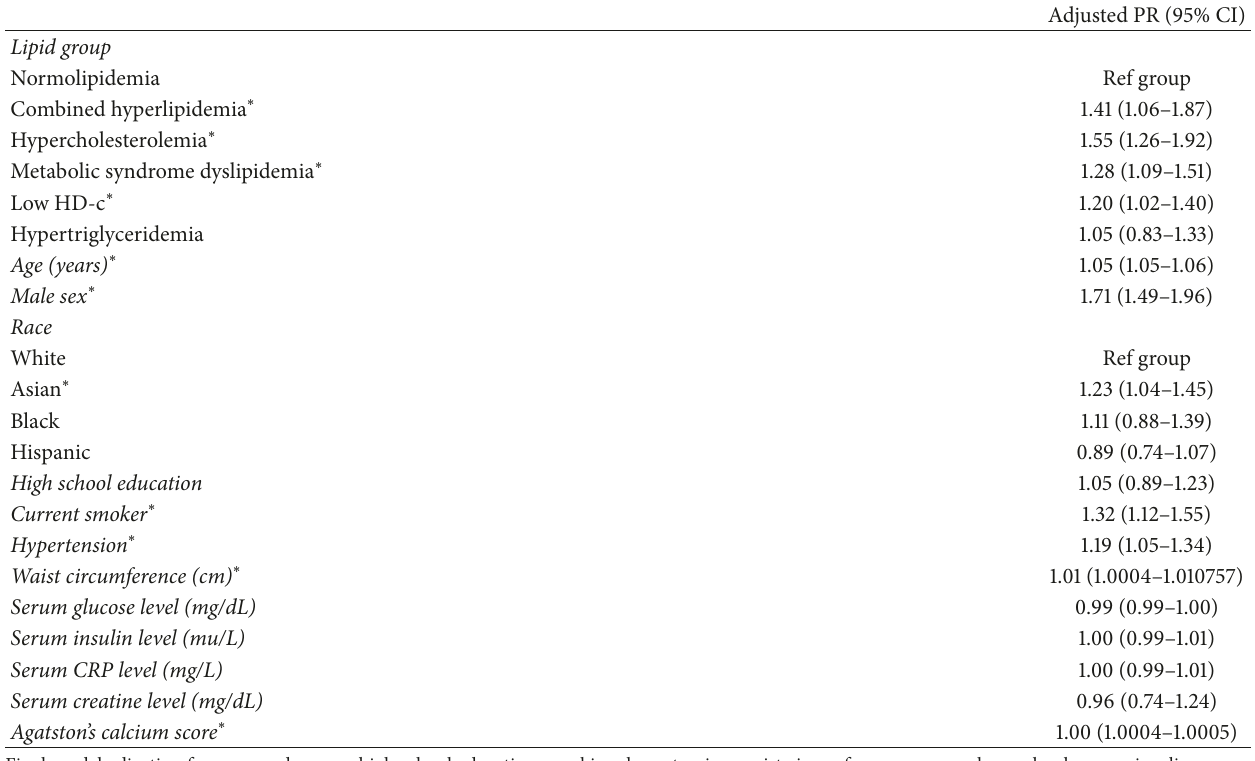
Table 4: Adjusted prevalence ratio of multivessel CAC as a function of lipid